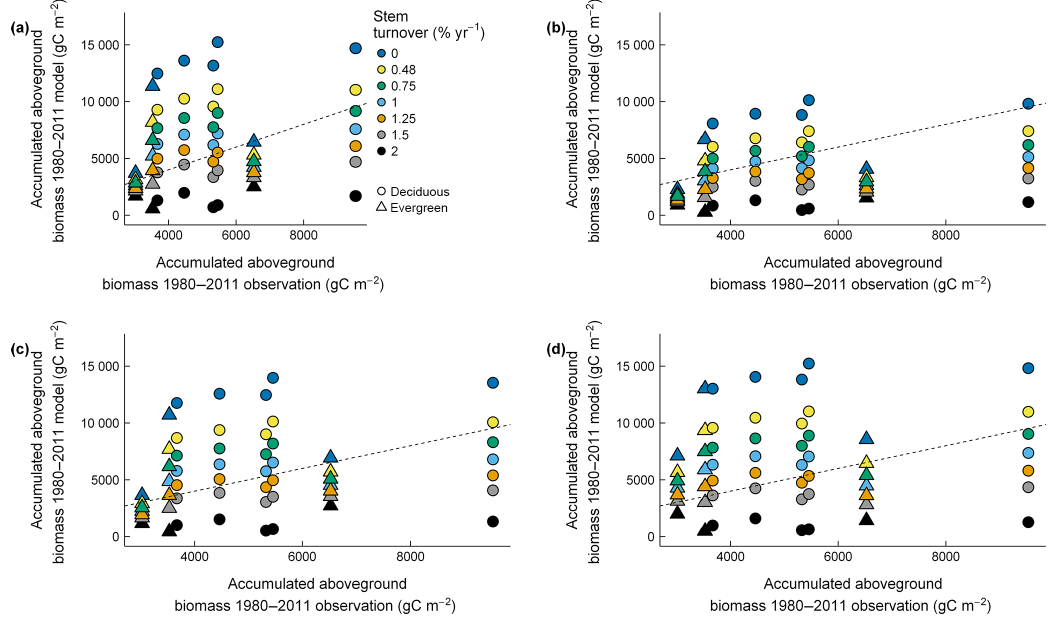
Figure 7. Comparisons between observed and modeled accumulated aboveground biomass 1980–2011 for (a) D-CLM4.5 allocation scheme, (b) D-Litton allocation scheme, (c) F-Evergreen allocation scheme, and (d) F-Deciduous allocation scheme. We assumed different turnover rates for stem from 0 to 2%yr − 1 . Turnover rate for stem in the model is 2%yr − 1 . Dashed line is 1 : 1 relationship between observations and model. Observations (aboveground biomass estimates from tree-ring data) are from Dye et al. (2016) for the Ha1 and Ho1 sites and following the methodology in Alexander et al. (2017) for the rest of sites.